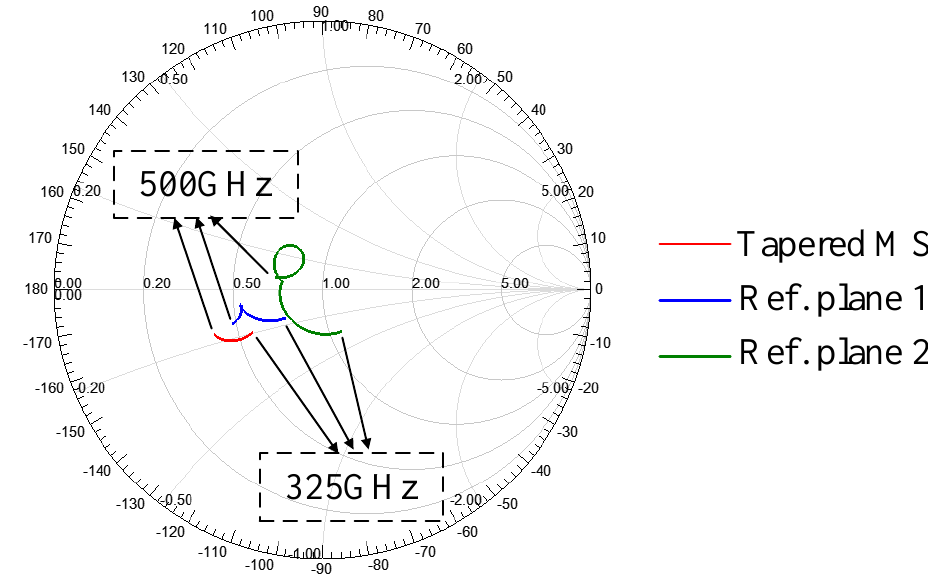
Figure 5. Smith chart of the reflection coefficients from 325 to 500 GHz at the tapered MSL section, at Ref. plane 1 and Ref. plane 2.